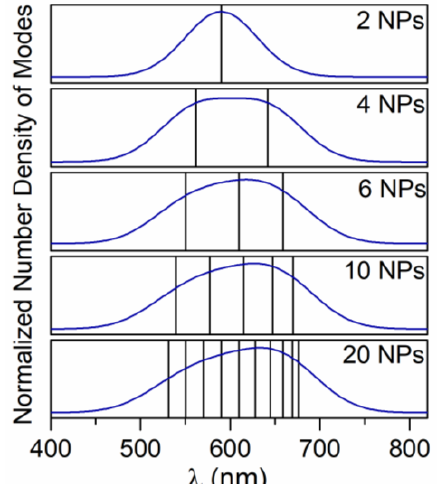
Figure 3. The image of the normalized number density of modes for chains with five di ff erent lengths. Black vertical lines represent single modes as obtained with the Variational Method, blue curves represent the density of states, calculated as a convolution of gauss curves modeled for each mode using a broadening of 80 nm for each state.